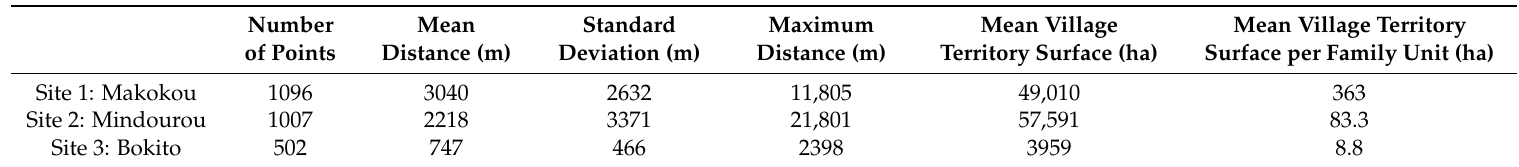
Table 1. Number of hunting, fishing and NTFP collection sites, mean and maximal distances to access collection sites of NTFPs from the village center, mean village territory surface and mean surface per family unit in the three study sites.